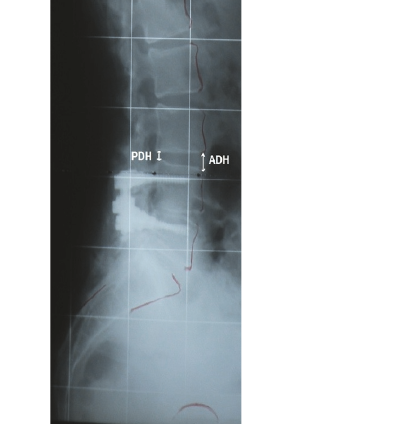
Figure 2: Anterior disc height ratio (ADHr) and posterior disc height ratio (PDHr).